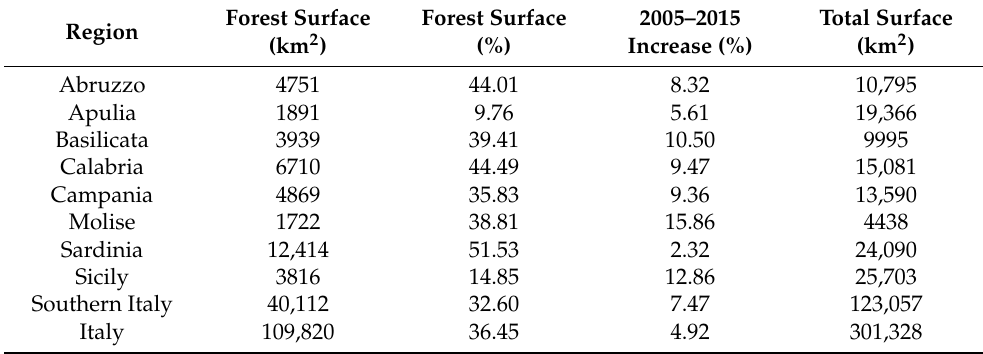
Table 3. Distribution of forests in Southern Italy, 2015 projections [29] (the actual 2015 data are